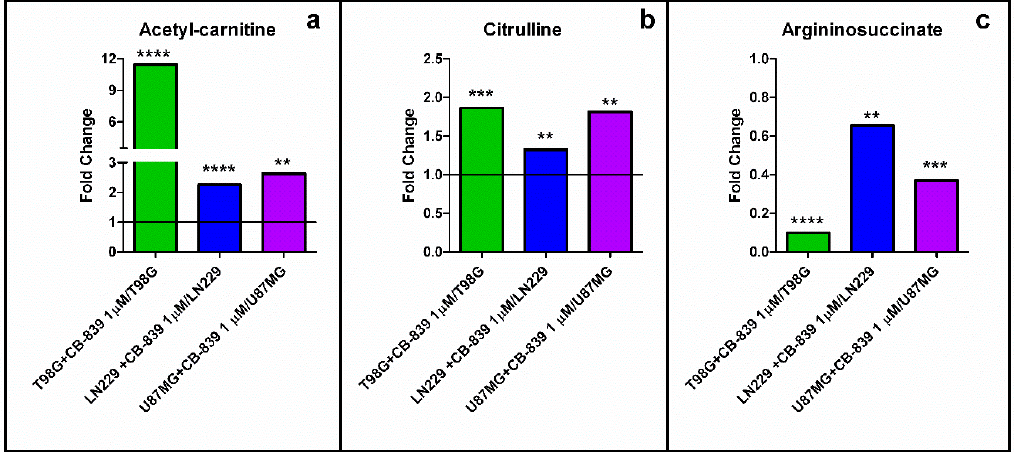
Figure 11. ( a ) Acetyl-carnitine and ( b ) citrulline significantly accumulated, while ( c ) argininosuccinate was depleted, following specific GLS inhibition by CB-839. The samples were run in triplicate. For more details, see Section 2. ** p < 0.01, *** p < 0.001, **** p < 0.0001.